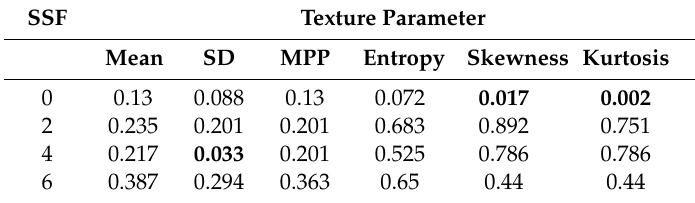
Table 3. Univariate analysis results for comparing benign and malignant groups. SSF